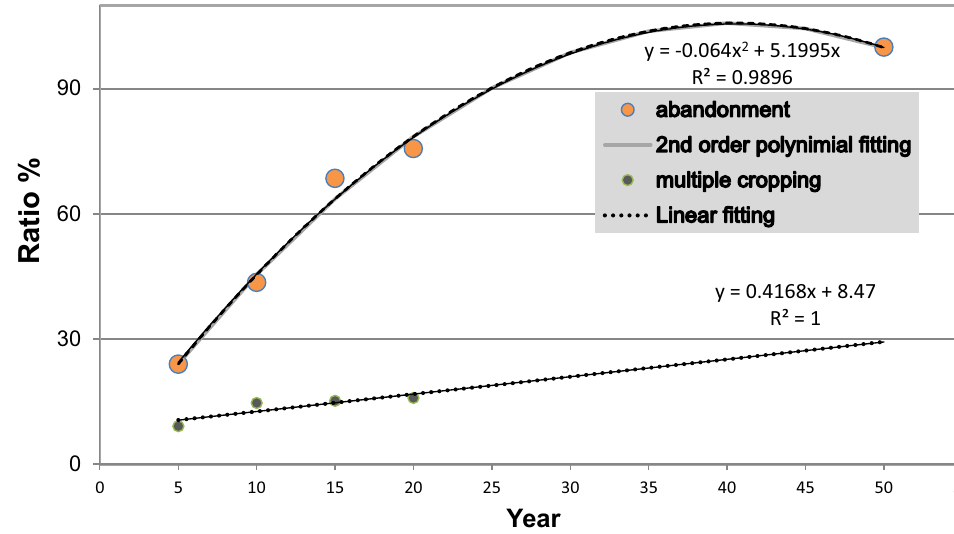
Figure 6. Statistical model showing how abandonment and replanting rates of eucalyptus plantations change with time.